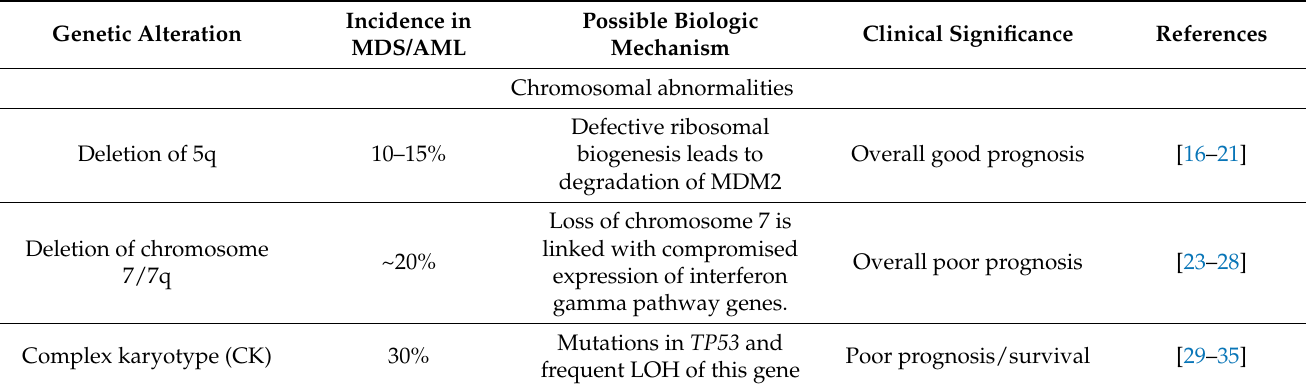
Table 1. The incidence, biologic mechanisms and clinical significance of genetic abnormalities in MDS and